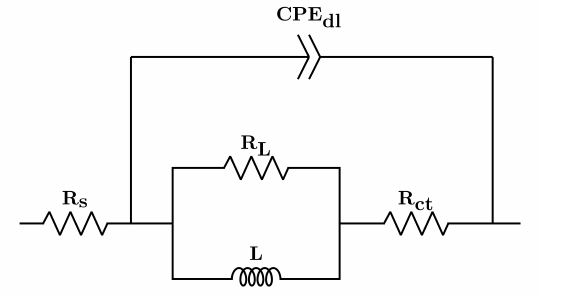
Figure 11. Equivalent circuit model of the interface between untreated, non-nitrided state and electrolyte.